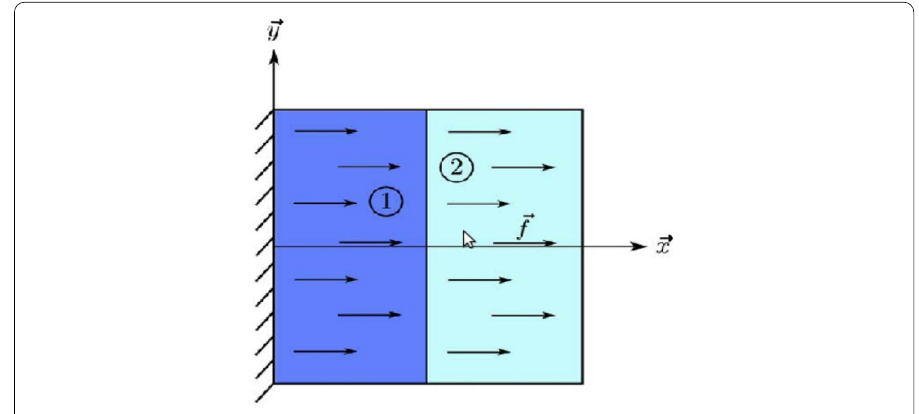
Fig. 39 Plate with a material interface and a variable volumic load